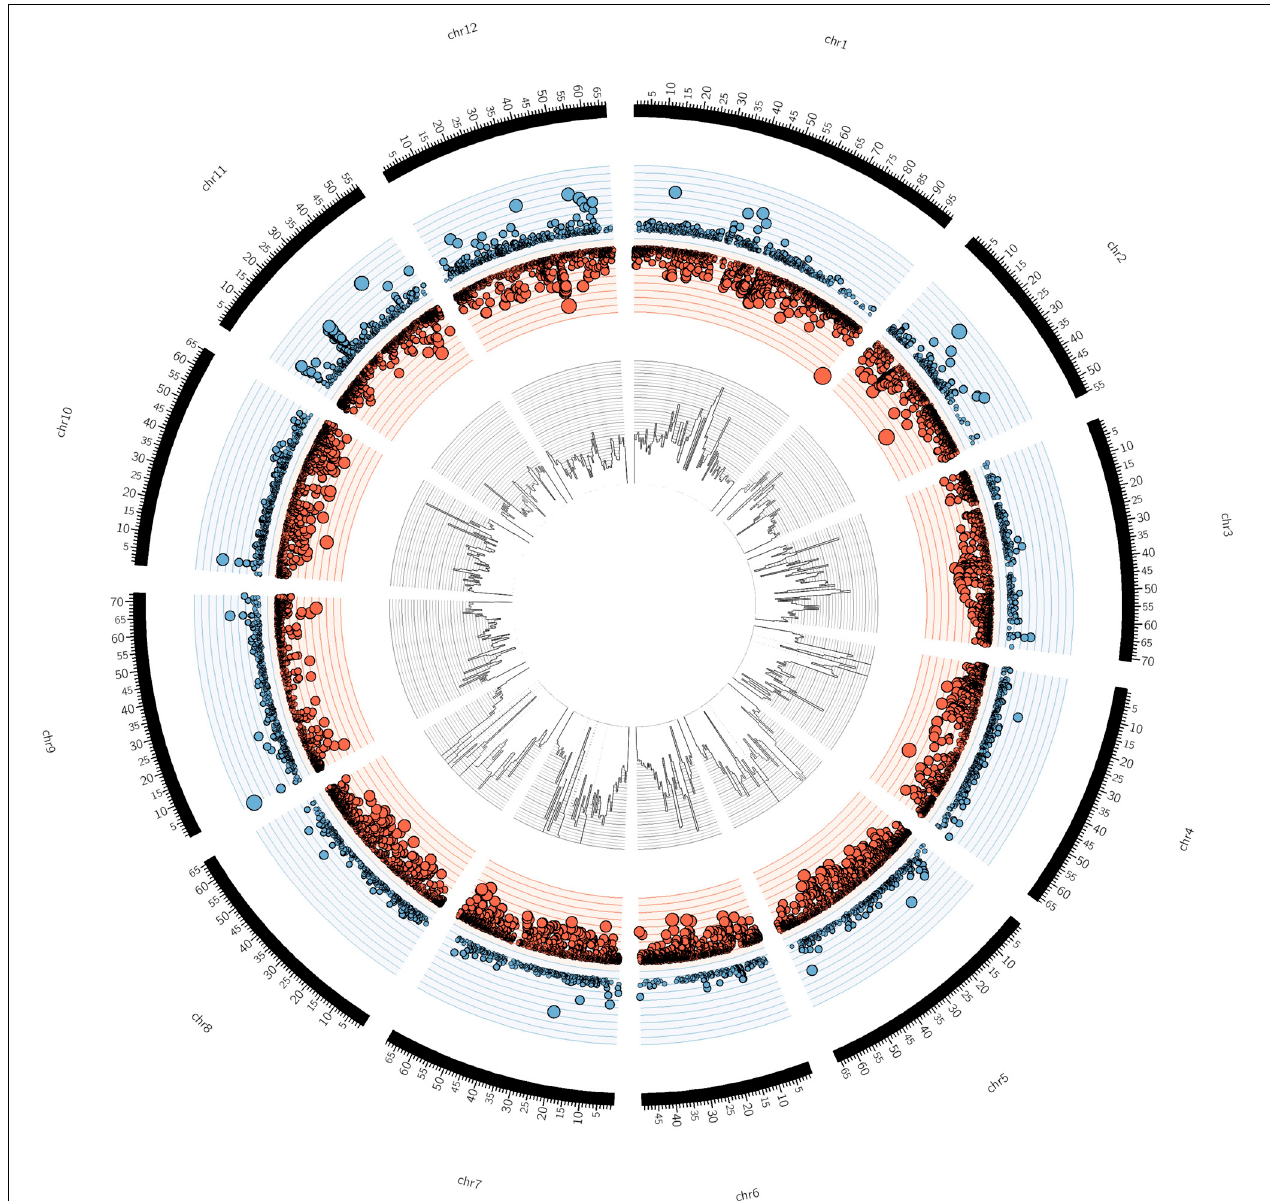
FIGURE 3 | Circular representation of S. pimpinellifolium genome structure in comparison with S. lycopersicum . From the outside to the inside: The outer layer represents the 12 chromosomes of S. lycopersicum , with the axis scale in Mb. The second layer (blue/red) represents the scatter plot of copy number variant (CNVs) regions with blue and red circles denoting high and low copy variants, respectively in S. pimpinellifolium relative to S. lycopersicum . The size of the circles is proportional to the absolute value of the log 2 CNV. The y -axis scale on the second layer corresponds to the log 2 CNV ranging from –10 to 10. The innermost layer represents the histogram of SNPs in 1 Mb bins. The y -axis scale on the innermost layer represents the SNP distribution between the two species, which ranges from 0 to 19,095 SNPs.